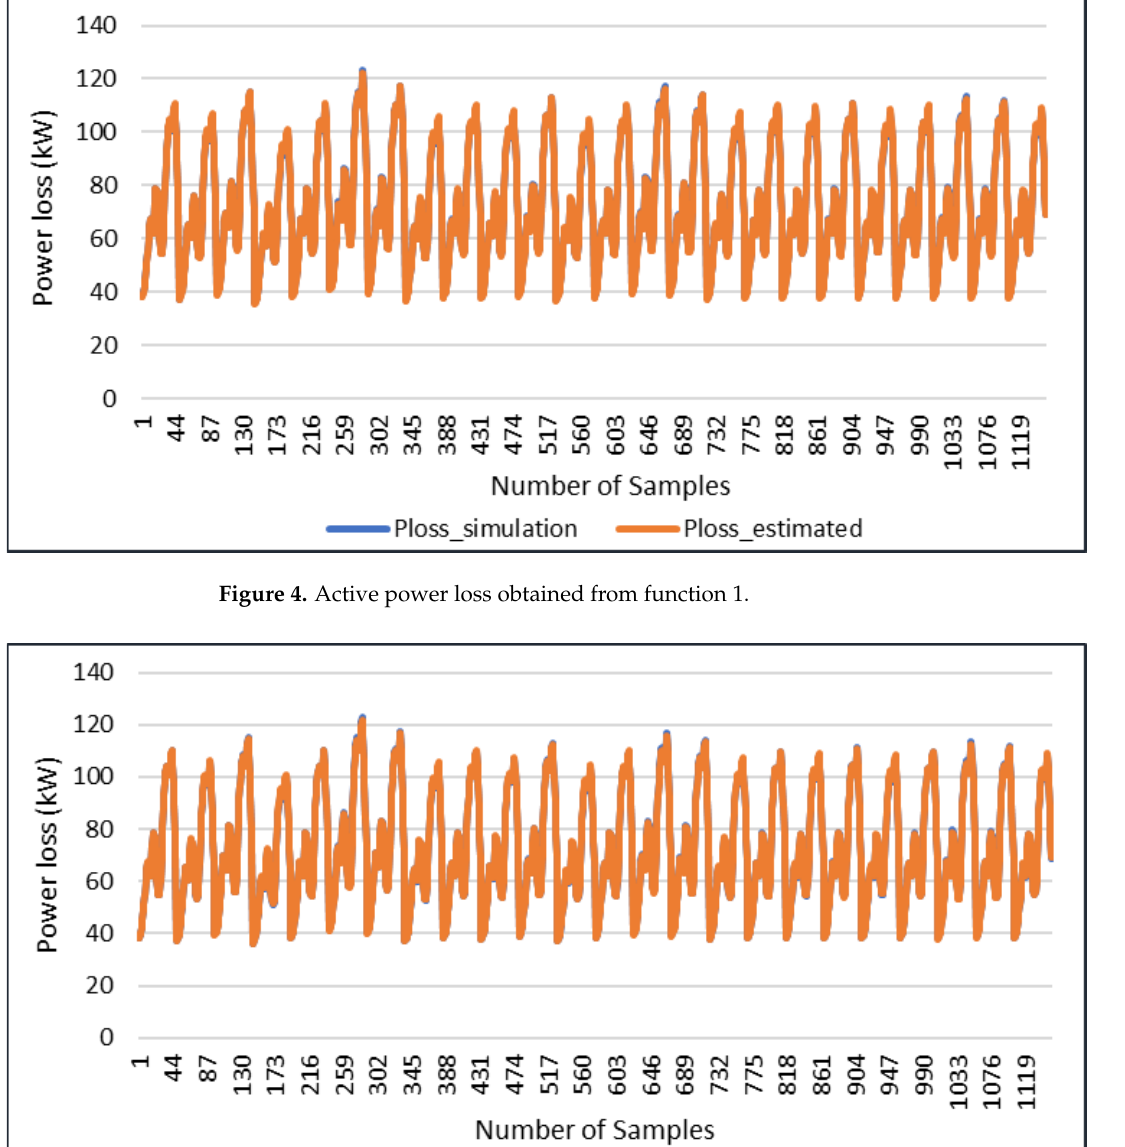
Table 9. RMS error for active power loss estimation for function 1 and 2 for IEEE-13 bus system.